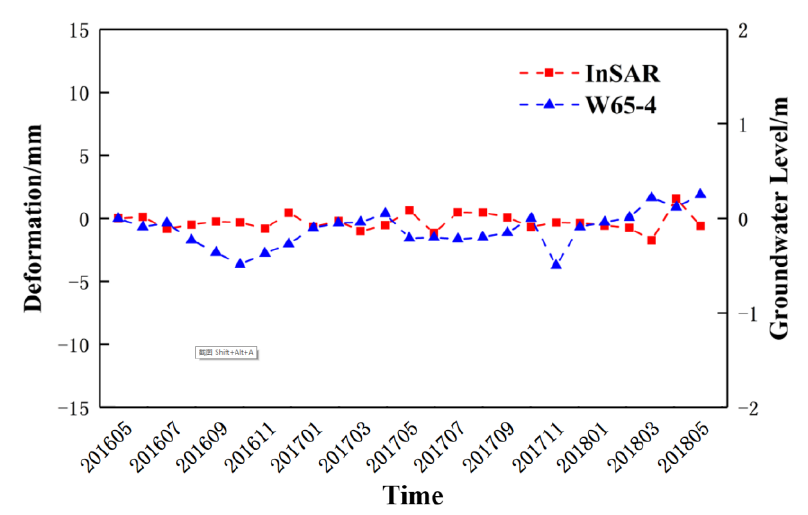
Figure 11. The relationship between PSInSAR derived deformation time series and groundwater level at well W65-4.